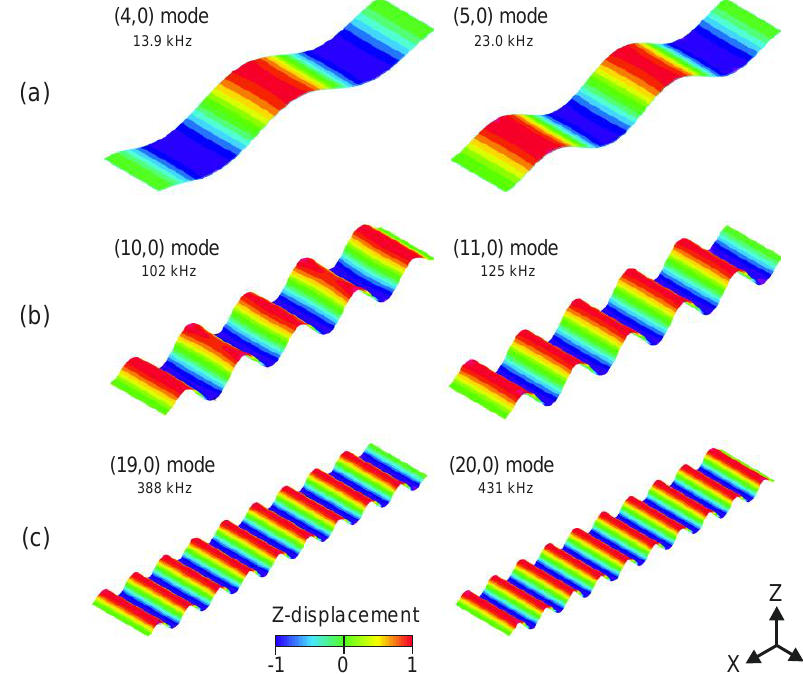
Figure 2. Mode shapes involved in the travelling waves (TW) generation obtained from the finite element method (FEM) analysis. ( a ) Modes (4,0) and (5,0) in the low frequency (LF) range, ( b ) modes (10,0) and (11,0) in the intermediate frequency (IF) range and ( c ) modes (19,0) and (20,0) in the high frequency (HF) range. Resonant frequency is also included. Colour bar represents the normalised modal displacement in the Z-axis.